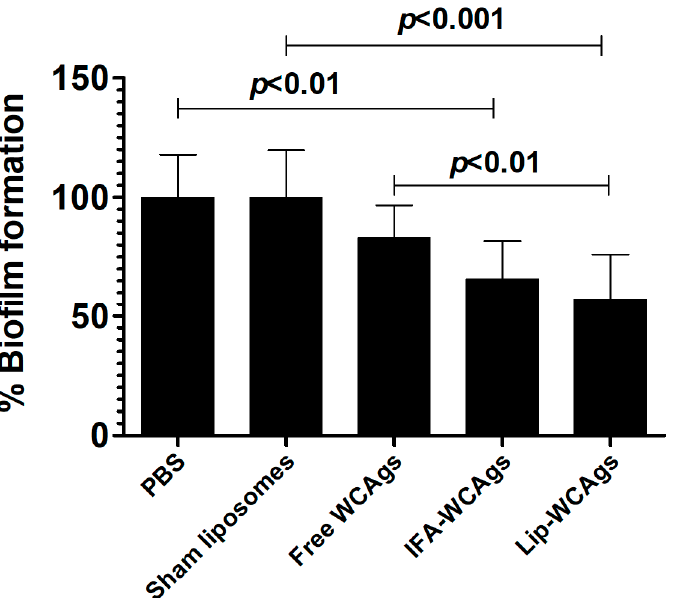
Figure 6. Antiserum from Lip-WCAgs-immunized mice showed the largest inhibition in biofilm formation. A. baumannii (1 × 10 6 CFUs/mL) was incubated with 10-fold diluted antisera for 24 h. After washing, the wells were dried and 0.1% crystal violet solution was added for 15 min. After washing, 50 µ L of ethanol was added to extract the stain and the absorbance of the content was taken at 595 nm. The data are expressed mean ± SD of three values.